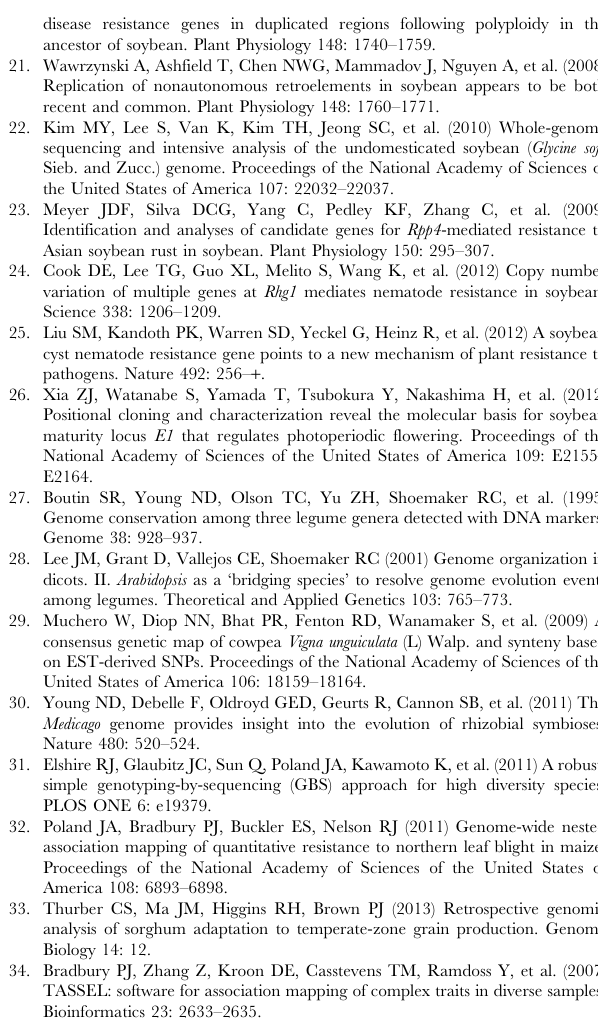
Figure S1 Genetic linkage maps of GBS markers in a Glycine latifolia F 2 population. (TIF) Figure S2 Genetic linkage maps of GBS markers in a Glycine latifolia F 5 population. (TIF) Figure S3 Consensus genetic linkage maps for Glycine latifolia derived from 3710 GBS markers.